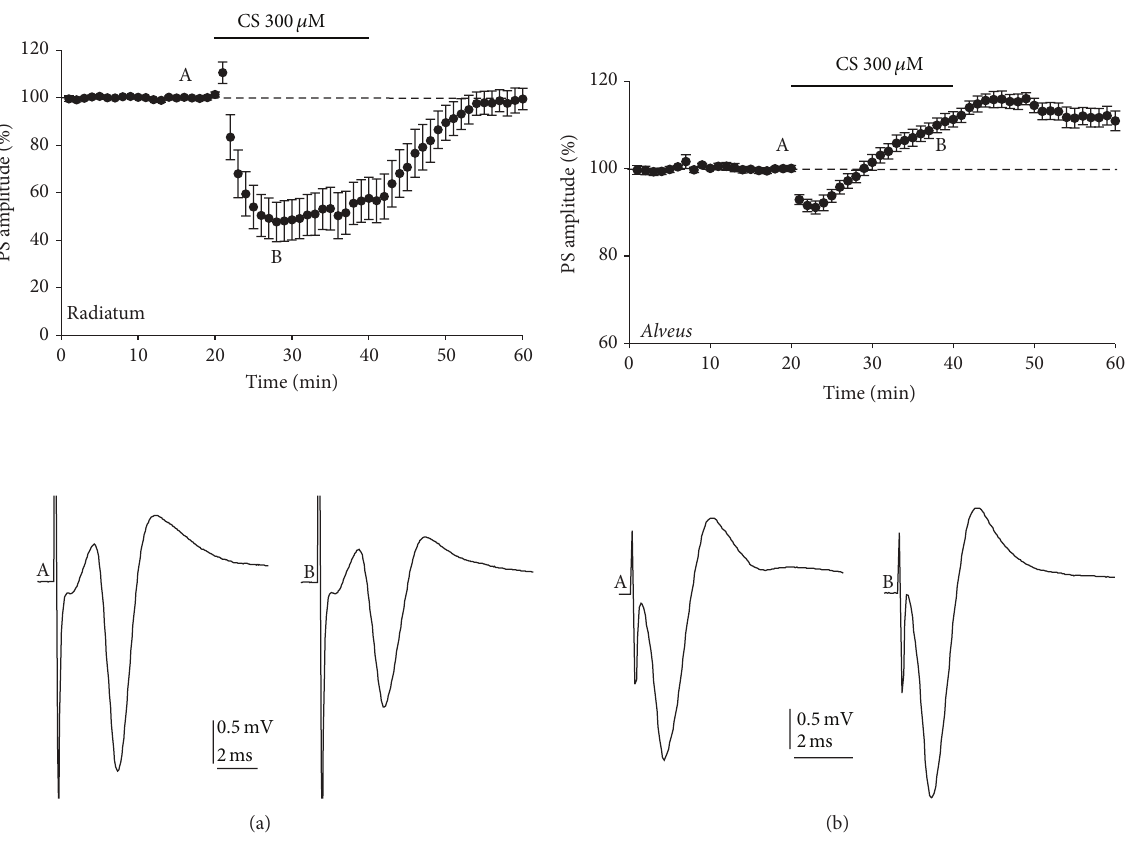
Figure 4: Variation in the amplitude of synaptic evoked population spike responses following CS treatment. (a) The time-courses show average population spike (PS) amplitudes evoked orthodromically by stimulation of stratum radiatum that reveal that CS induces a drastic depression of their amplitude in a reversible manner. Bottom panels show representative PS taken at the times indicated by the letters A (control) and B (CS). (b) Time-courses of average PS amplitudes evoked antidromically by stimulation of stratum alveus and how CS was able to enhance their amplitude in a reversible manner. As indicated above, the original traces show representative population spike taken at the times indicated by the letters A (control) and B (CS). The graph plots data were normalized to the mean value of the 20 min control period and expressed as mean ± SEM/min ( 𝑛 = 6 – 11